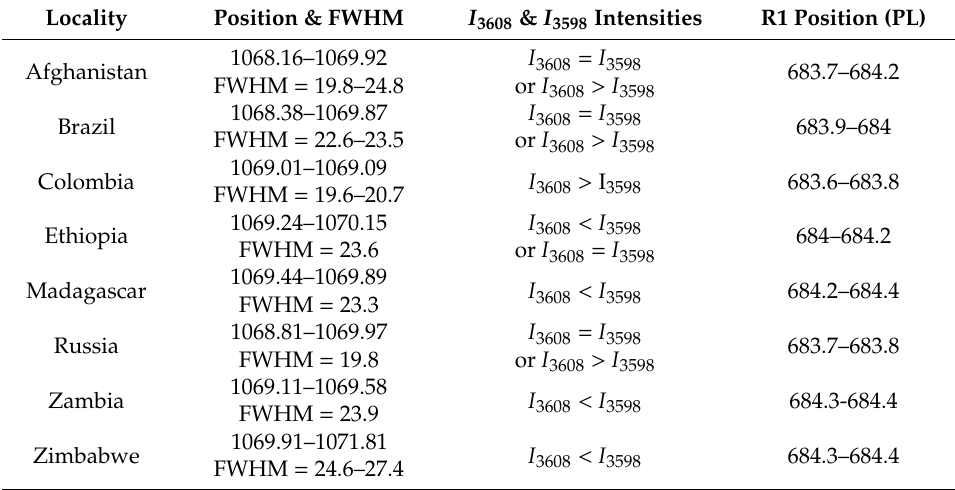
Table 5. Position and FWHM of the Raman band at around 1070 cm − 1 , relative intensities of the Raman bands at 3598 cm − 1 and 3608 cm − 1 and position of the R1 photoluminescence bands for the samples from di ff erent localities. All observations were made using spectra acquired with a laser beam perpendicular to the